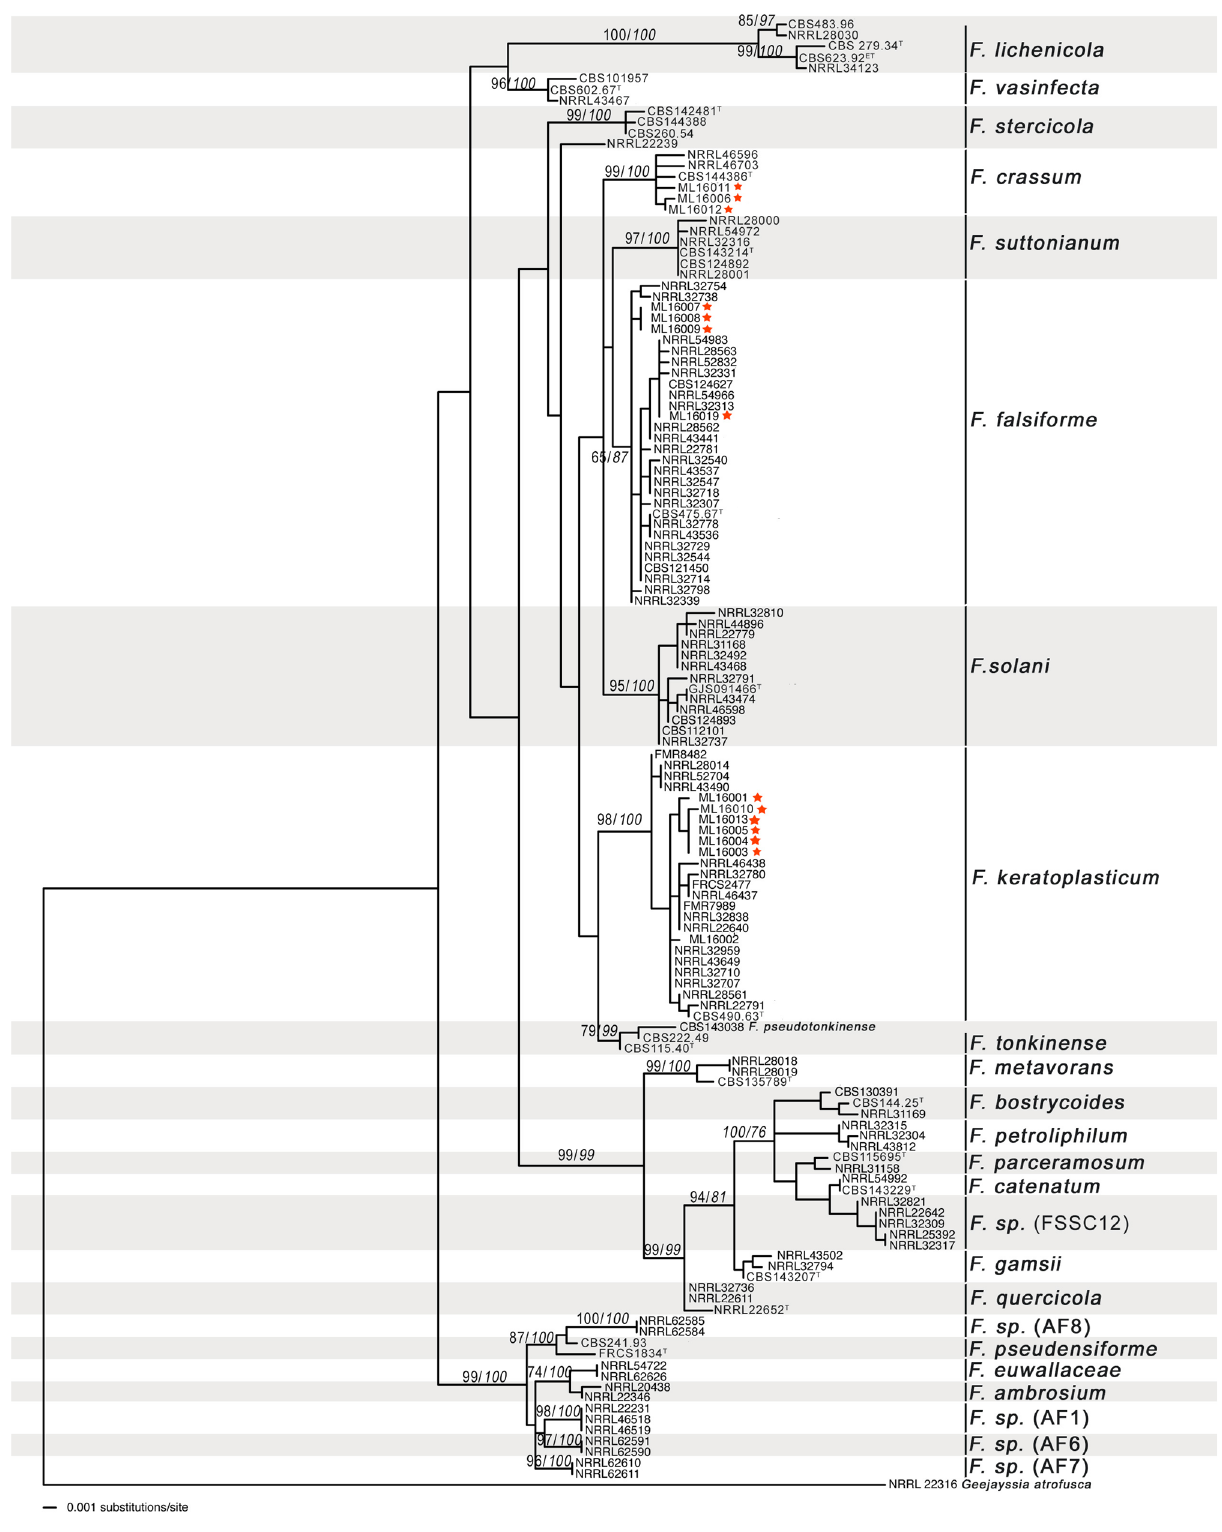
Figure 2. Maximum likelihood analysis of Fusarium species isolates based on three loci, translation elongation factor 1 α ( tef1 ), large subunit (LSU) and internal transcribed standard (ITS). Numbers within the tree represent the bootstrap values of 1 000 replicates, followed by the posterior probability (italics). Strains isolated during this study are marked with a red asterisk